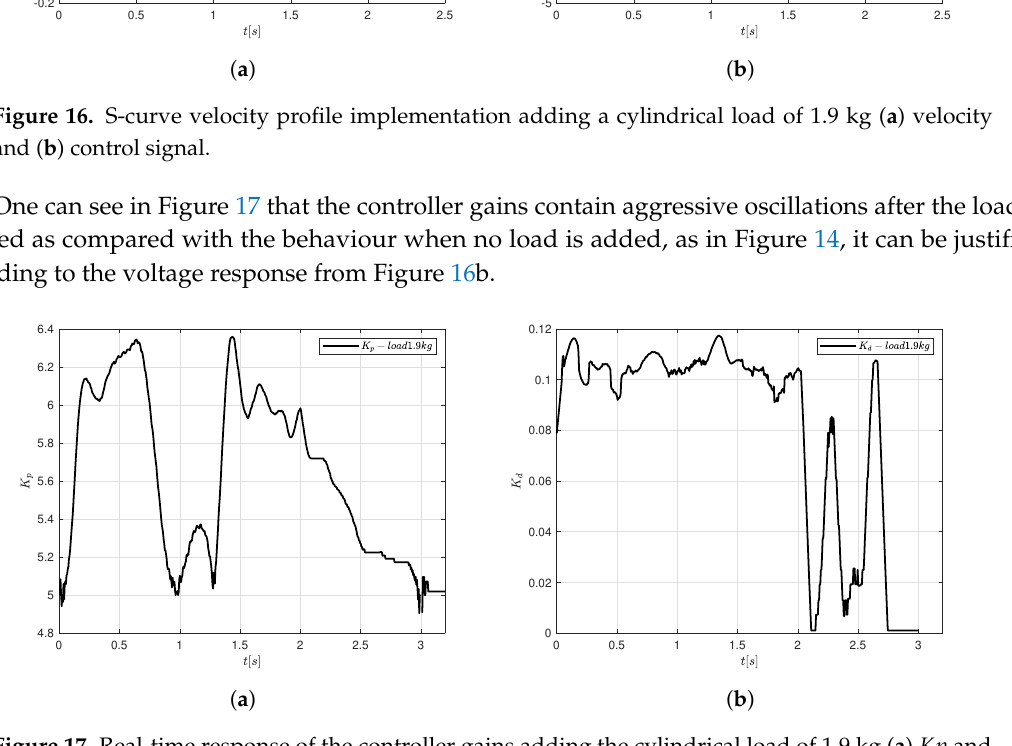
Figure 17. Real-time response of the controller gains adding the cylindrical load of 1.9 kg ( a ) Kp and ( b ) K d